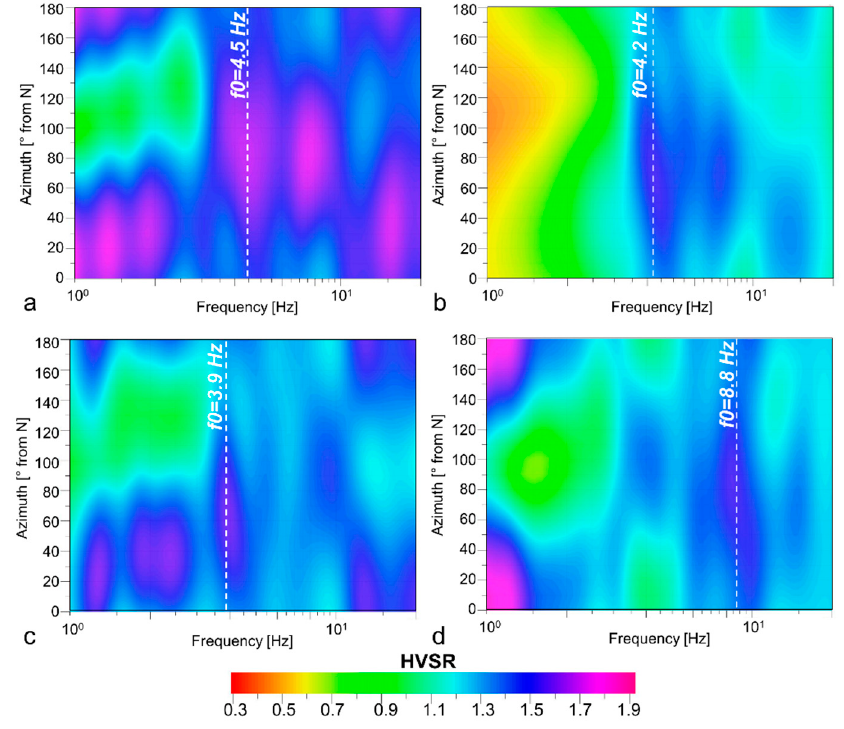
Figure 8. Directional HVSR azimuth (in degrees from N direction) on stations ( a ) A, ( b ) B, ( c ) C and ( d ) D. In each panel, the white dashed lines highlight the location of the highest spectral peaks (f0) identified in Figure 7.